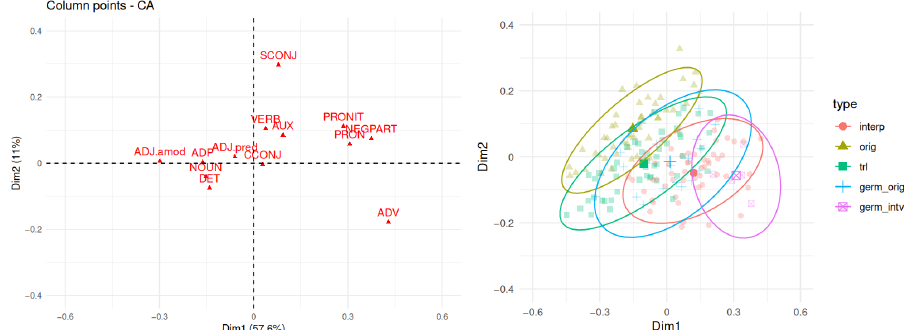
Figure 5. Correspondence Analysis based on all text types (originals, translations and interpretations), columns (variables) at the left and rows (texts) at the right.